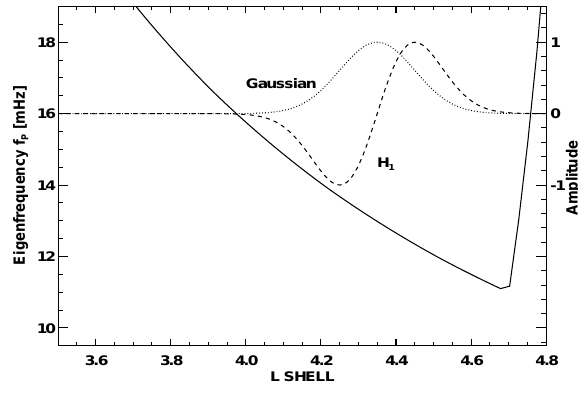
Fig. 12. Comparison between the modeled radial variation and the radial variation of the poloidal